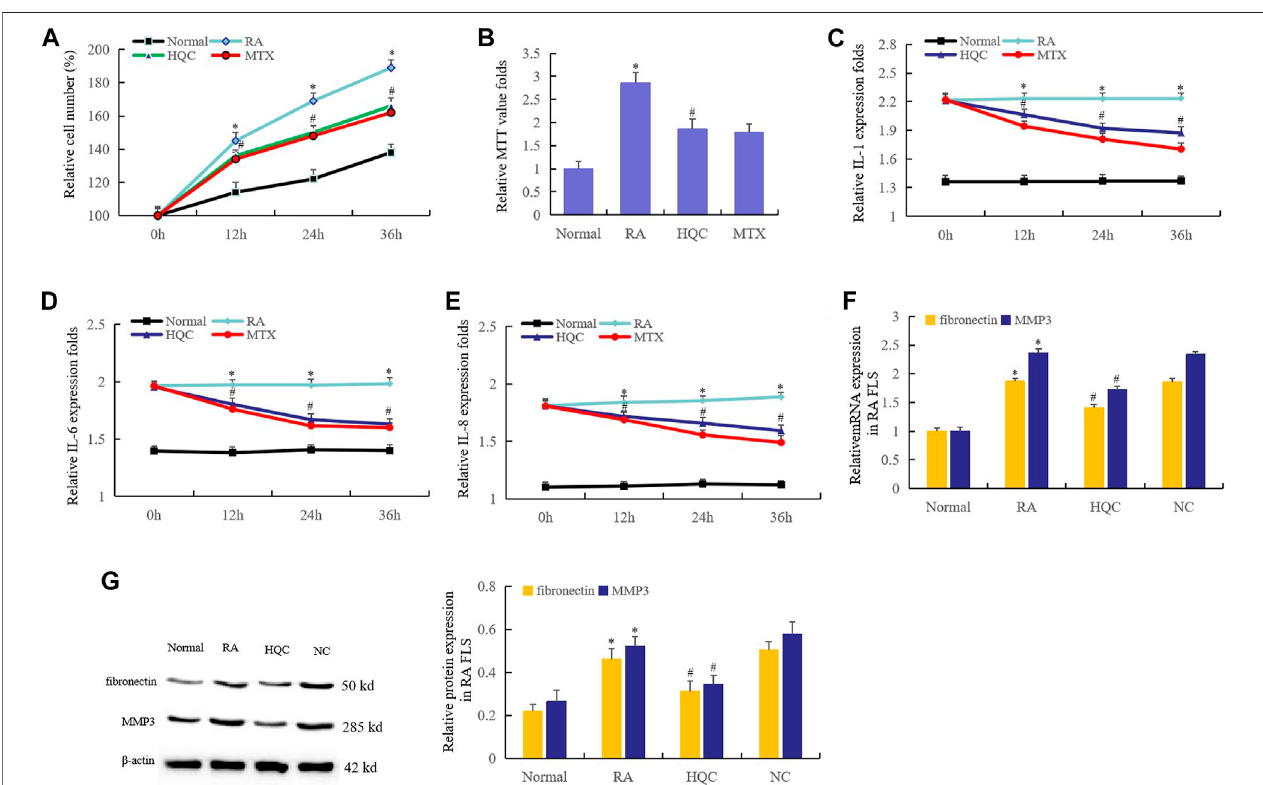
FIGURE 2 | HQC inhibited the proliferation of RA FLS. The effects of HQC on RA was evaluated using RA FLS. (A) : the effect of HQC on RA FLS growth was detectedbycellcounting; (B) :theeffectofHQConRAFLSgrowthwasdetectedbyMTT; (C) :theeffectofHQContheIL-1secretionwasdetectedbyELISA; (D) :ELISA was used to detect the effect of HQC on IL-6 secretion; (E) : the effect of HQC on the IL-8 was detected by ELISA; (F) : the roles of HQC in the expression of MMP3 and fi bronectin at theRNA levels were detected byreal time qPCR; (G) : the rolesofHQCin theexpression of MMP3 and fi bronectin at the protein levels weredetected by western blotting. *RA FLS group was compared with normal group; # HQC group was compared with RA FLS